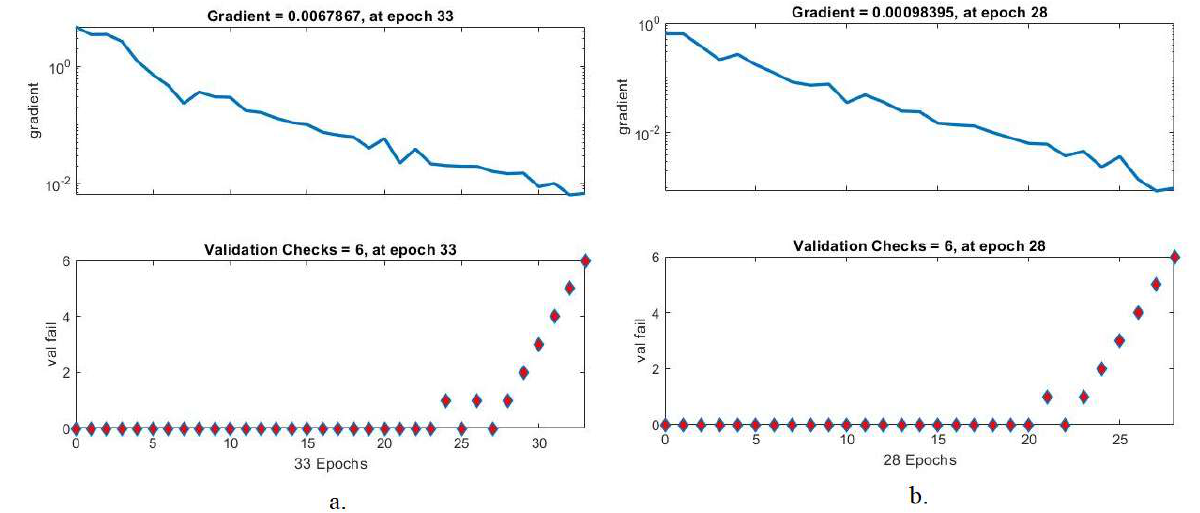
Figure 9. Gradient for evaluating ANN performance based on hybrid features. ( a ) AlexNet, DWT, LBP, FCH, and GLCM; ( b ) ResNet-18, DWT, LBP, FCH, and GLCM.